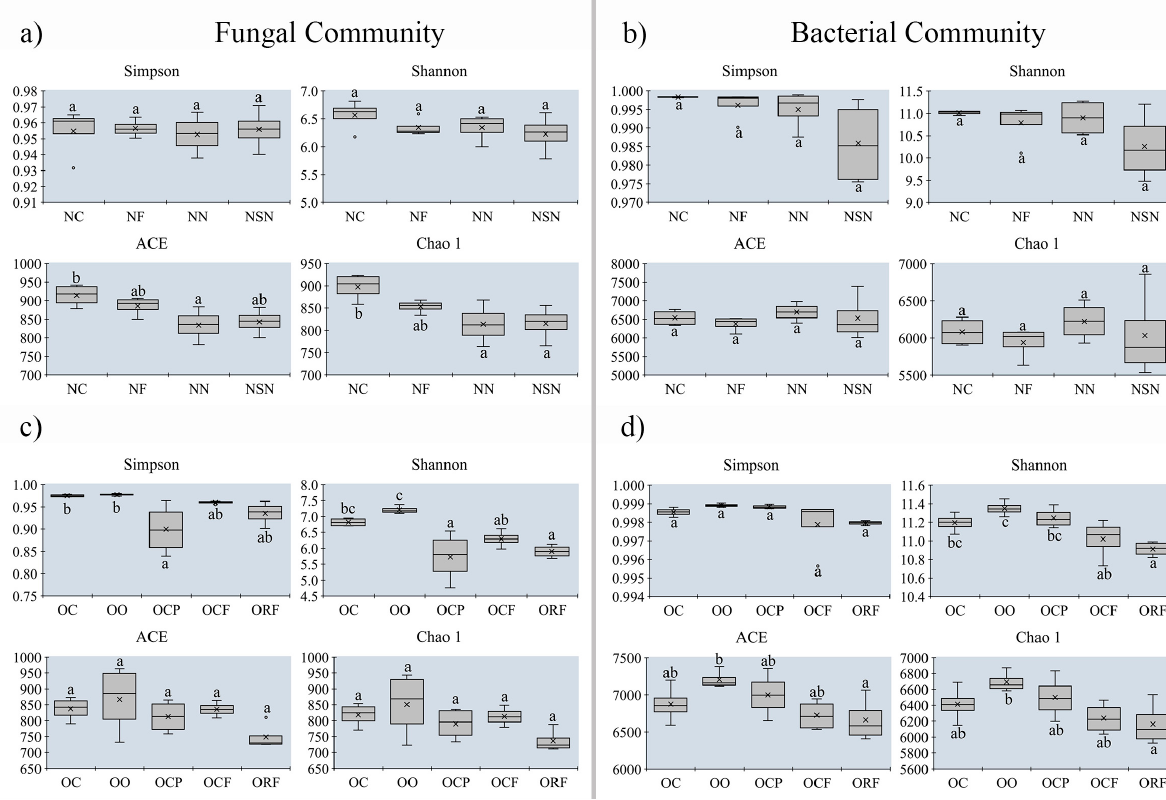
Figure 6. Alpha-diversity estimators of the soil fungal ( a , c , e ) and bacterial communities ( b , d , f ) of the investigated morel farms. For individual index boxes, different letters indicate significant differ- ences at p = 0.05 (ANOVA) between means (Tukey’s HSD pairwise comparisons, n = 4). Remarkably, the alpha-diversity indices had no significant difference between OC and OO, which showed, after a year of cessation cultivation, the diversity and richness in the soil where morels have been cultivated may be expected to recover (Figure 6c,d). 3.6. Co-Occurrence Patterns of Microbial Communities Associated with Morel Production To investigate differences in the co-occurrence patterns related to morel production, eleven high-yield soil samples (group II: SM1, SM2, SM3, WD1, WD2, WD3, GH4, GH5, NF, OCF, and ORF) and seven low- or no-yield soil samples (group III: SM0, GH1, GH2, GH3, DY1, NN, and NSN) were selected for network analysis, respectively.